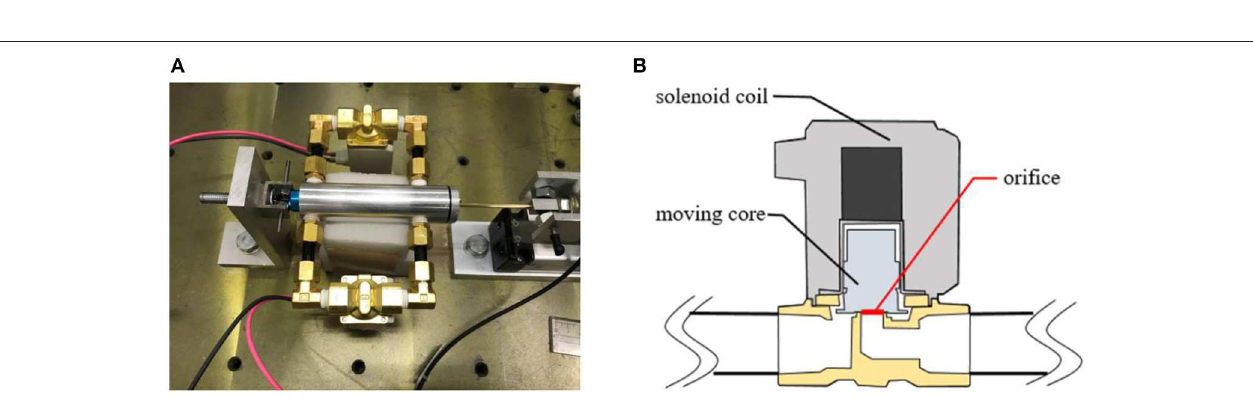
Frontiers in Built Environment |